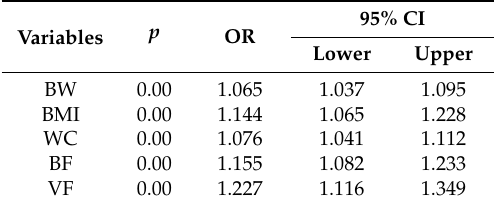
Table 4. Logistic Regression Analysis for Determining IR.